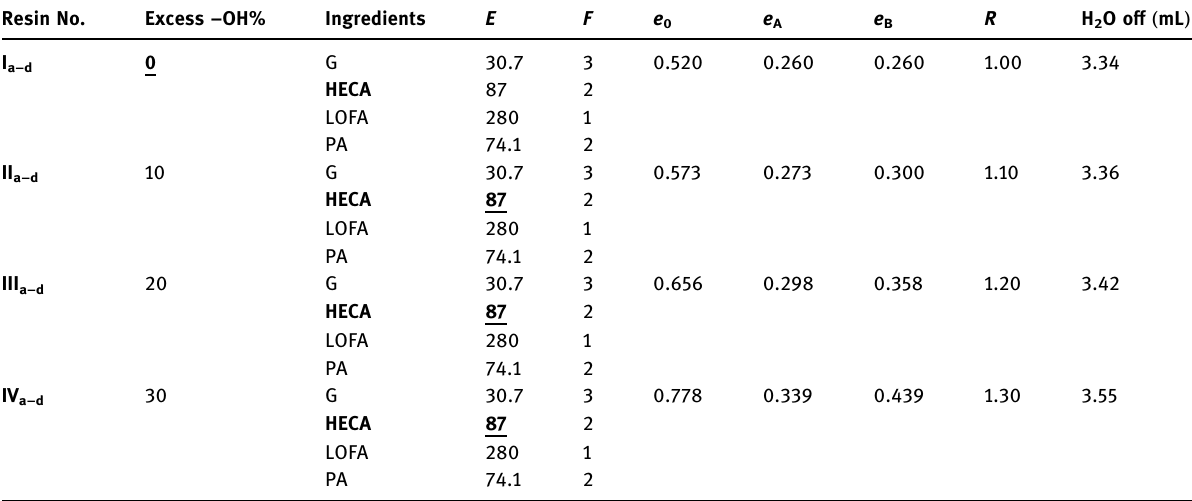
Table 1: Resin constants for HECA – modi fi ed alkyd resins Resin No.